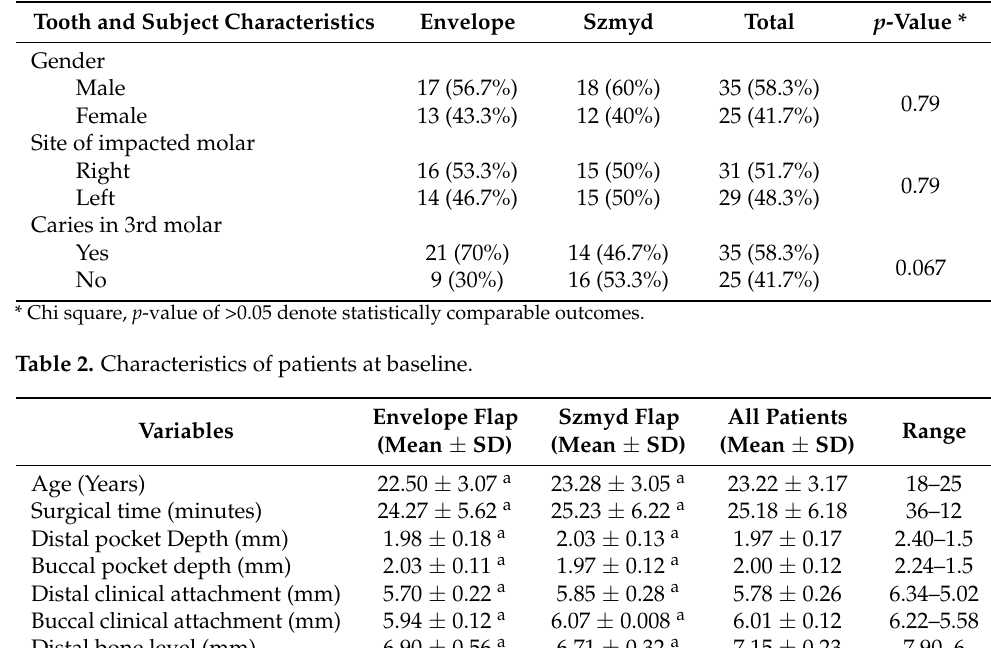
Table 1. Comparison of tooth and subject characteristics in study groups.